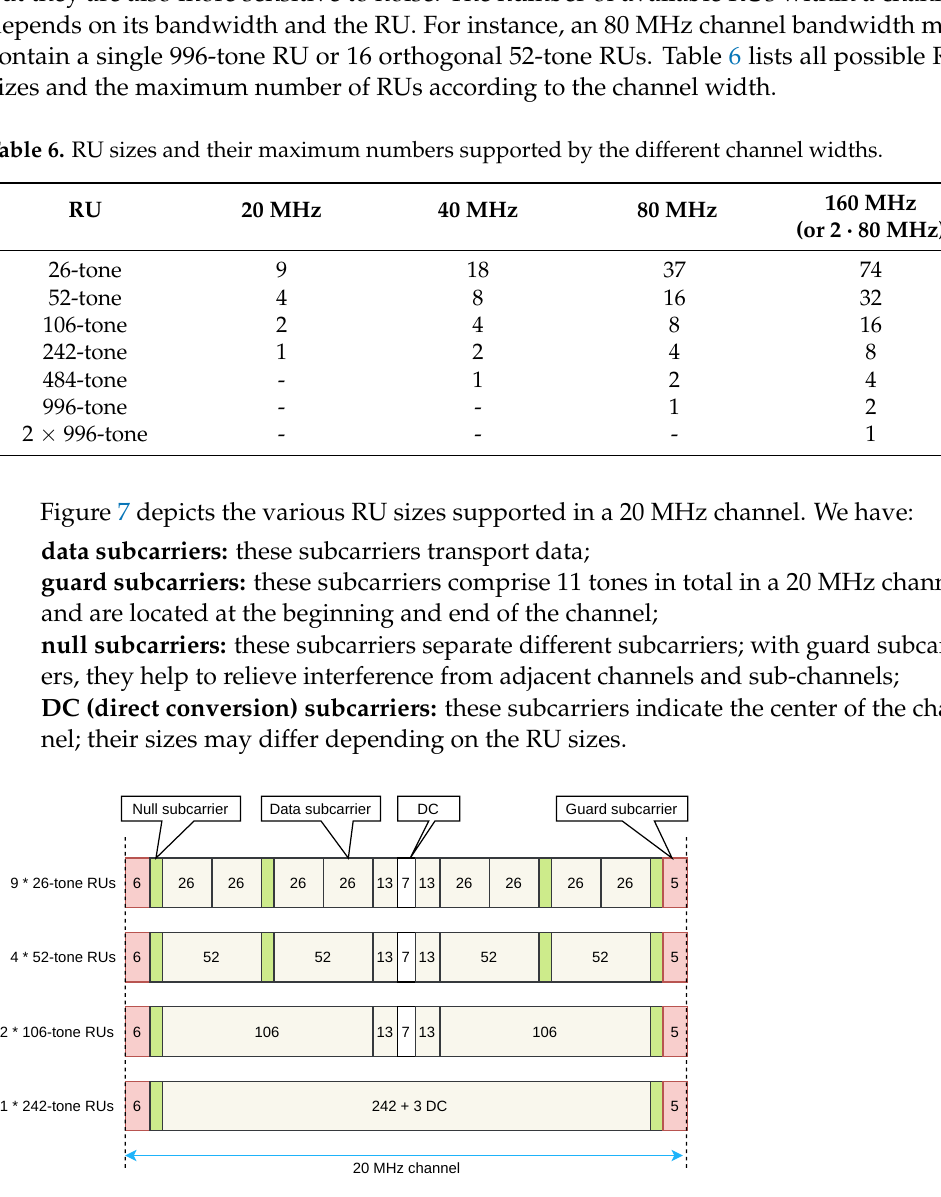
Figure 7. RU sizes in a 20 MHz